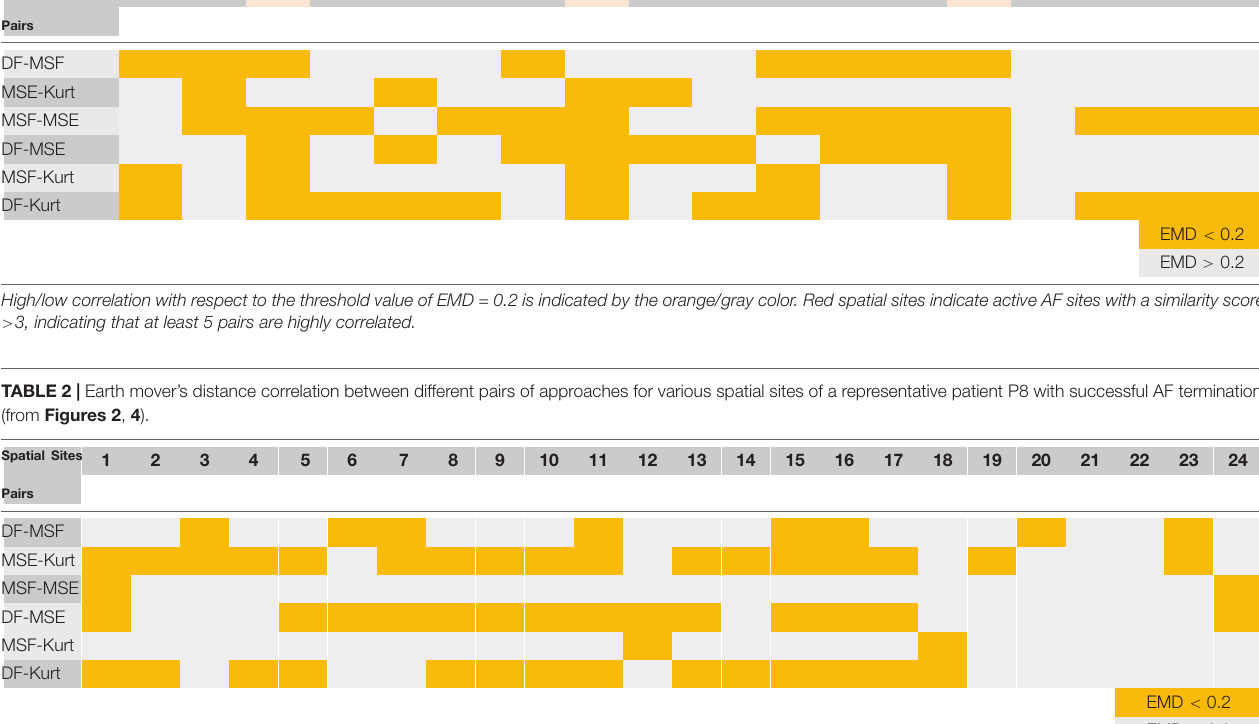
TABLE 1 | Earth mover’s distance (EMD) correlation between different pairs of approaches for various spatial sites of a representative patient P1 with unsuccessful atrial fibrillation (AF) termination (from Figures 1 , 3 ). Spatial Sites